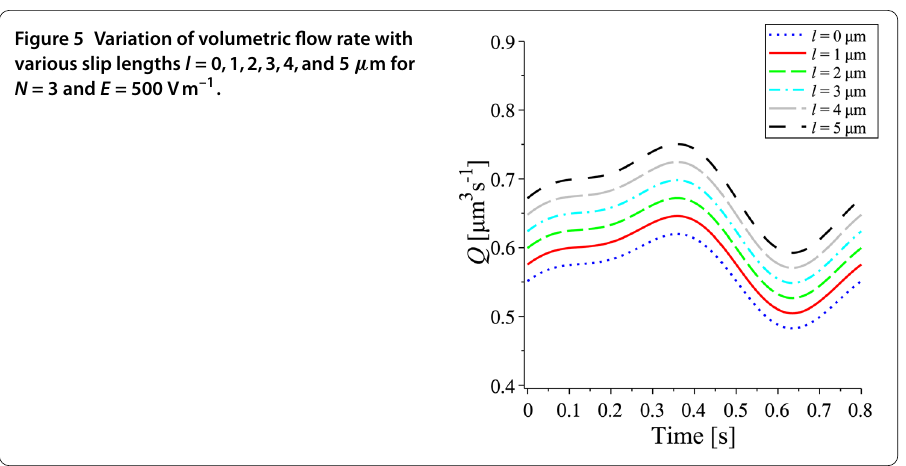
Figure 5 Variation of volumetric flow rate with various slip lengths l = 0,1,2,3,4,and 5 μ m for N = 3 and E = 500 Vm –1